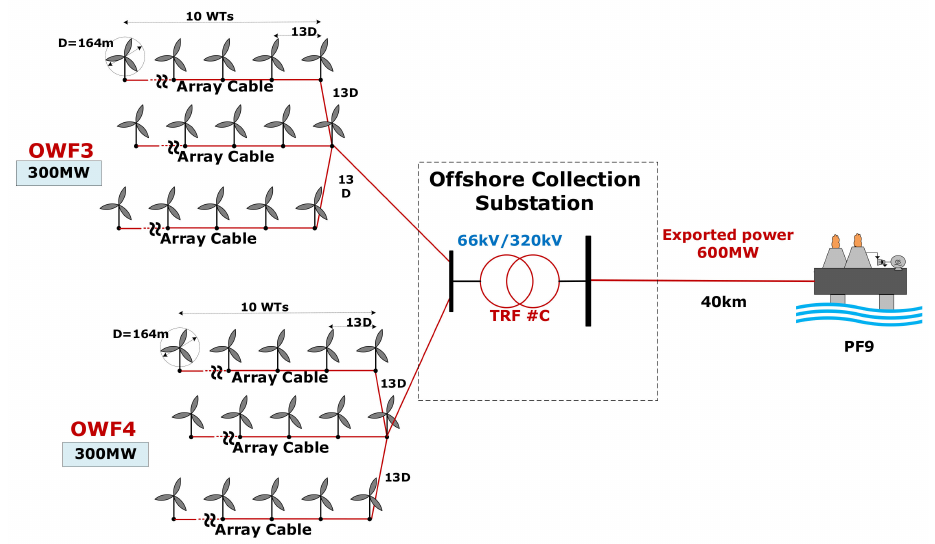
Figure 4. Case-3 OWFs WTs and power collection